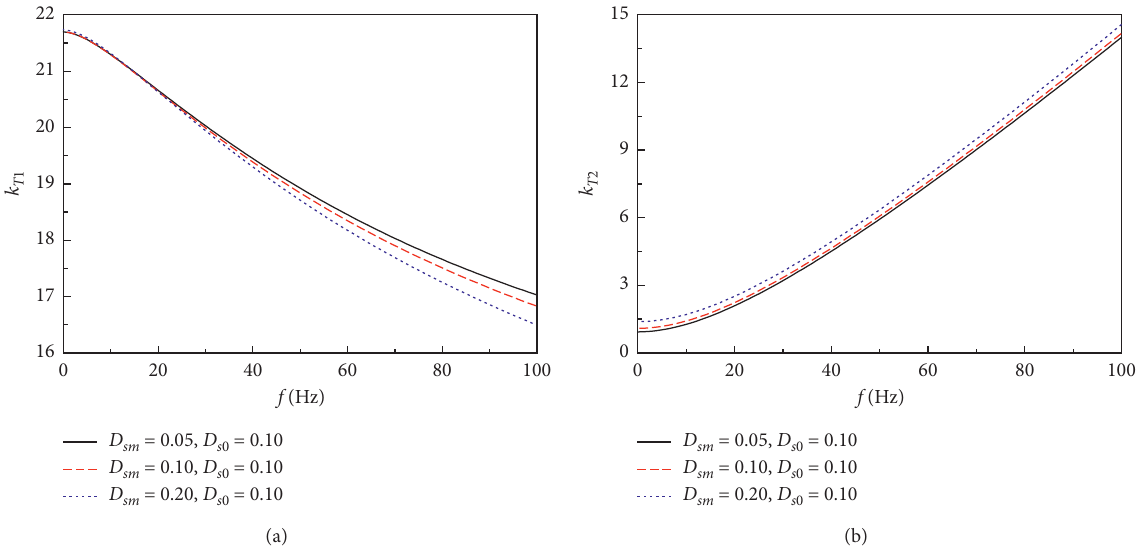
Figure 10: Influence of material damping of the inner disturbed soil on the complex stiffness at the pile top when the inner soil is strengthened ( GR � 2, t m / r 0 �